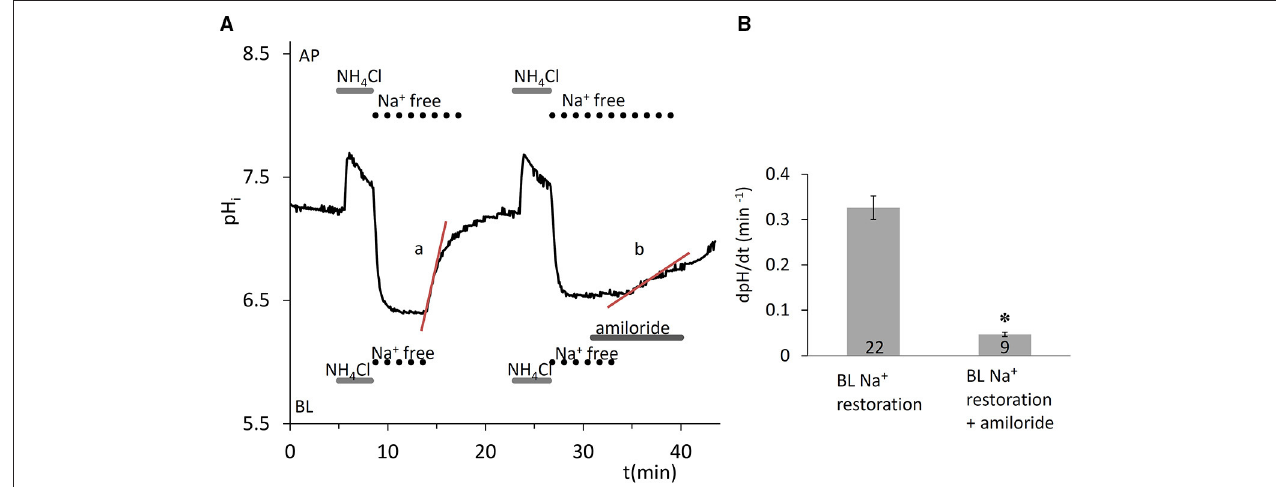
FIGURE 1 | Recovery of pH i in HAT-7 cells exposed to an acid load in the absence of HCO − 3 /CO 2 . (A) HAT-7 cells grown on Transwell membranes were exposed bilaterally to 20mM NH 4 Cl followed by bilateral substitution of Na + with NMDG + . Recovery of pH i (a) can be seen following basolateral restoration of external Na + . Inhibition of pH i recovery (b) can be seen following restoration of Na + in the presence of basolateral (BL) amiloride (300 µ M) in order to selectively block the NHE1 exchanger. (B) Mean dpH/dt ( ± SEM) values were calculated from the initial rates of increase in pH i following restoration of Na + in the presence and absence of the inhibitor ( n = 9–22). * p < 0.05 compared with